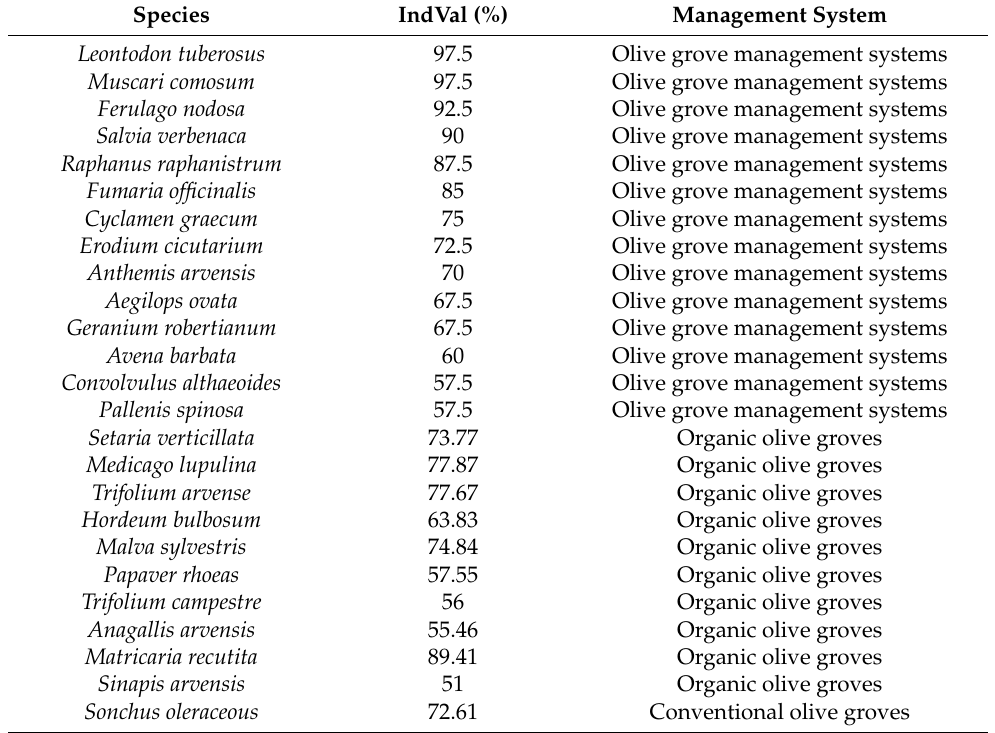
Table 6. IndVal analysis for herbaceous plant